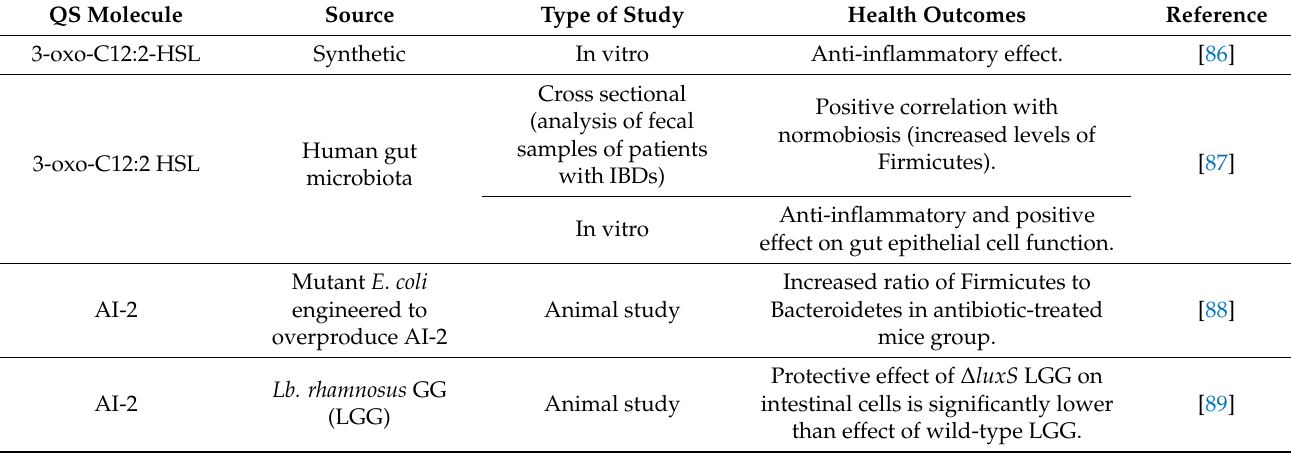
Table 3. Association of QS molecules with gut